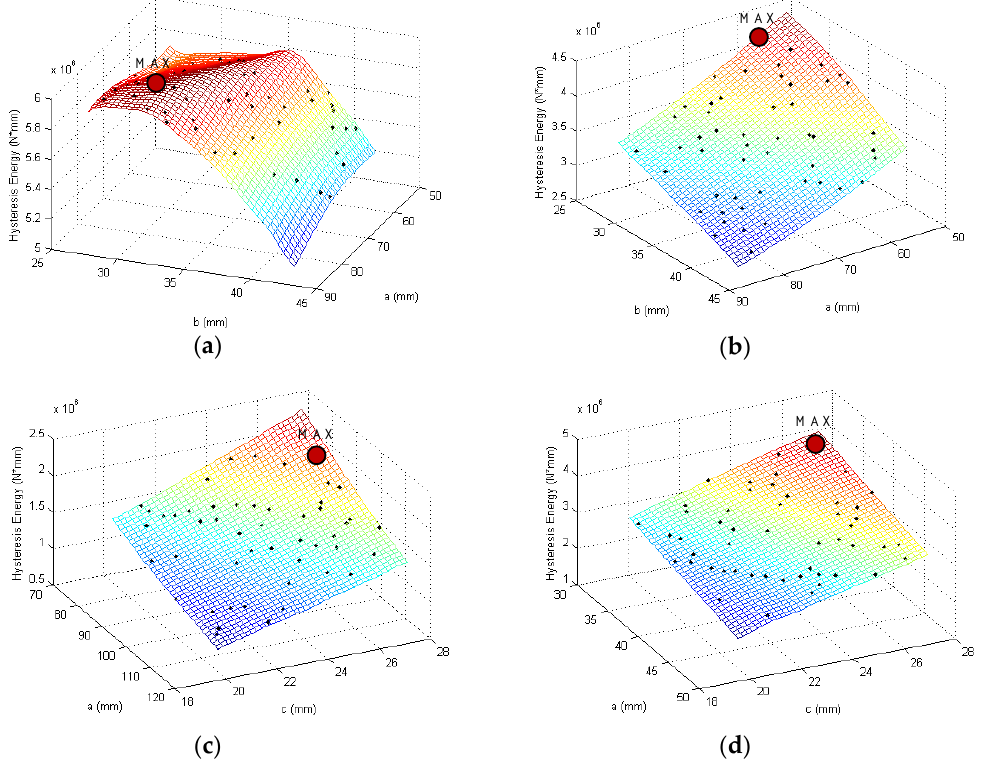
Figure 5. The Kriging model for four kinds of coupling beam metal dampers: ( a ) SP1; ( b ) SP2; ( c ) SP3; and ( d ) SP4.